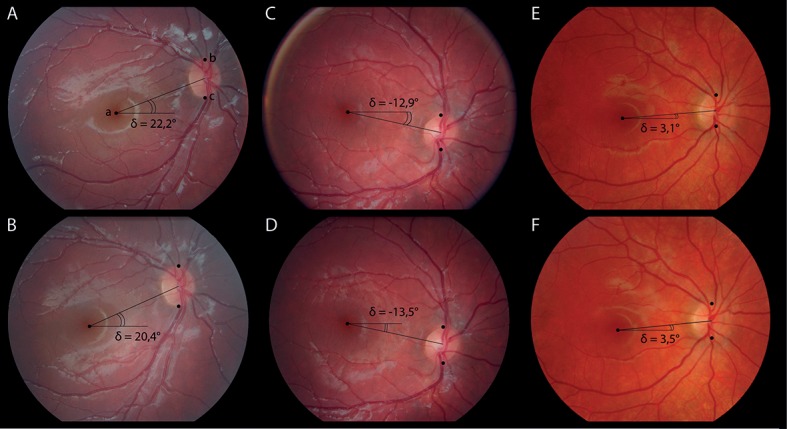
Examples of disc-foveal angle stability between NMFP 1 and NMFP 2 in a V-Pattern strabismus (A and B), a healthy child (C and D) and an A-Pattern strabismus (E and F).